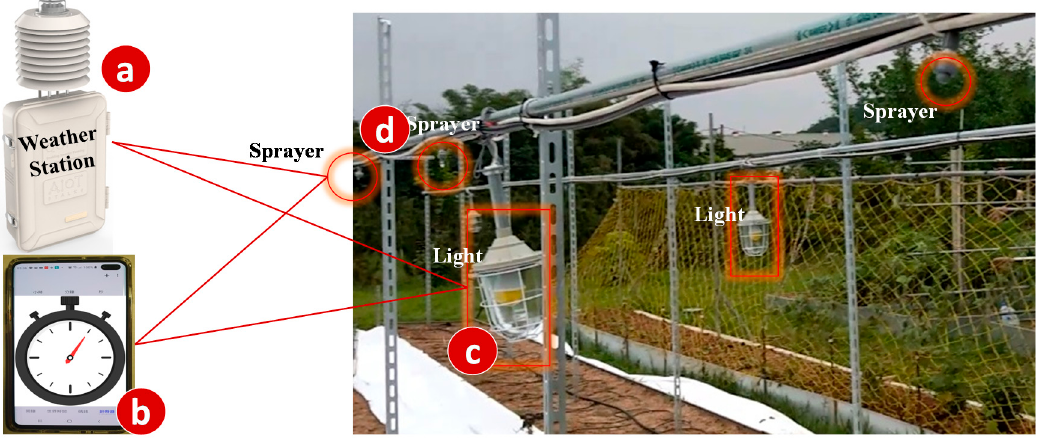
Figure 2. A simplified smart farm service.